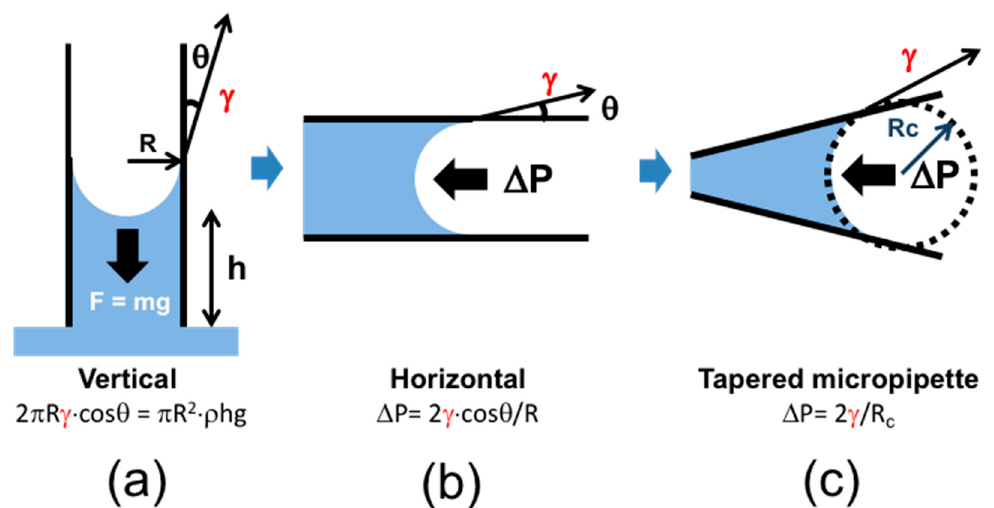
Figure 3. Capillary actions of the air-water surface. ( a ) Capillary-rise of water inside a vertical capillary. Upon dipping the capillary tube into the liquid, meniscus rises against gravity a distance h above the outside bulk surface. At equilibrium, this height reaches a force balance that follows the Young–Laplace equation between gravity and wetting (mg versus 2 π R γ cos θ ). ( b ) In the horizontal capillary immersed in an aqueous-filled microscope chamber, the water comes inside the horizontal capillary until opposed by a counter force such as applying a pressure to the back-end of the pipette to hold it in position or push it back. Again, the force balance follows the Young–Laplace equation of pressure opposed by the surface tension scaled by the reciprocal of the single radius. ( c ) Similarly, for a tapered micropipette where the meniscus position is now opposed requiring a series of increasing applied pressure to move the surface down the taper. It is this tapered pipette that has been the most useful and is the basis for our tension measurements.